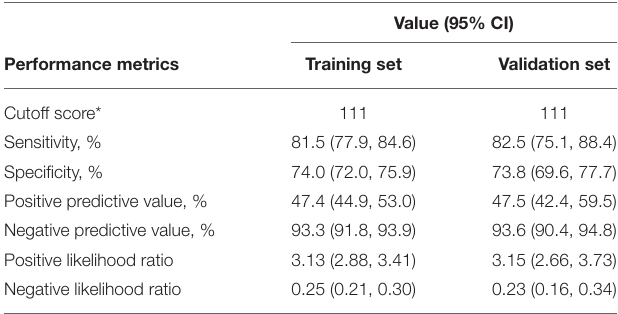
TABLE 5 | Performance metrics of the nomogram for estimating the risk of 72-h mortality after admission.